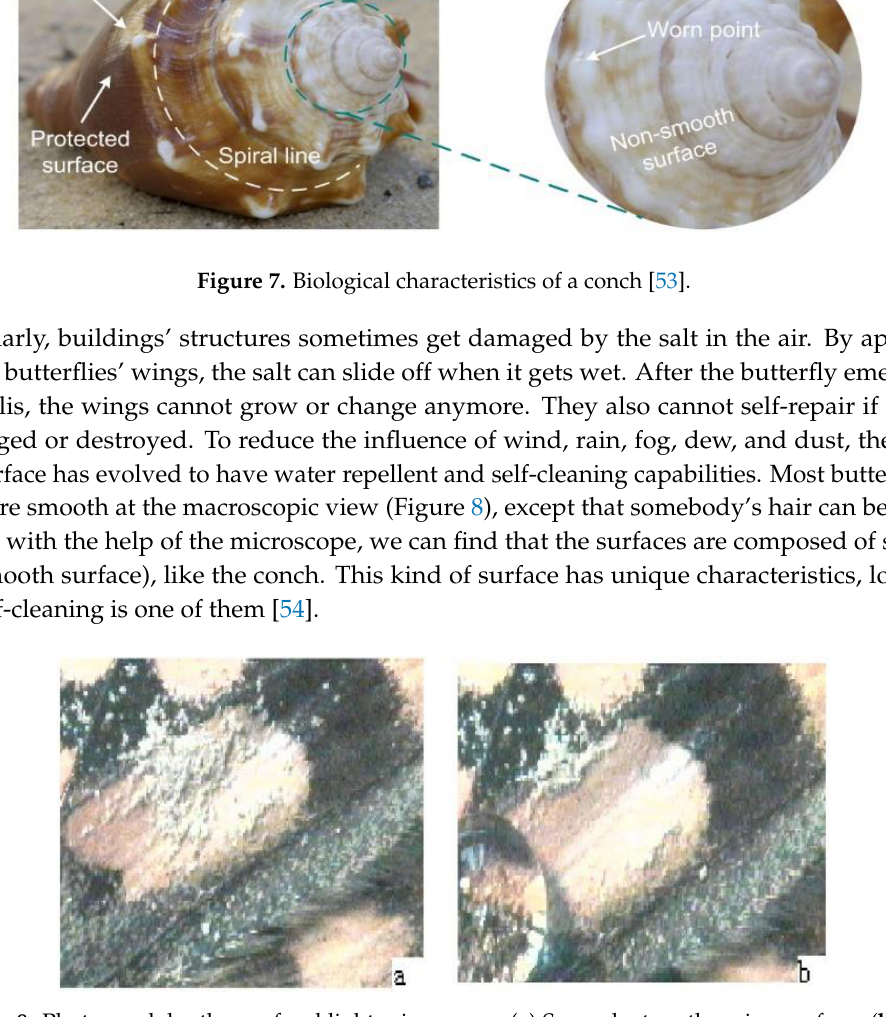
Figure 8. Photograph by the confocal light microscope. ( a ) Some dust on the wing surface. ( b ) The moving spherical water droplet can clean the dust on the wings surface